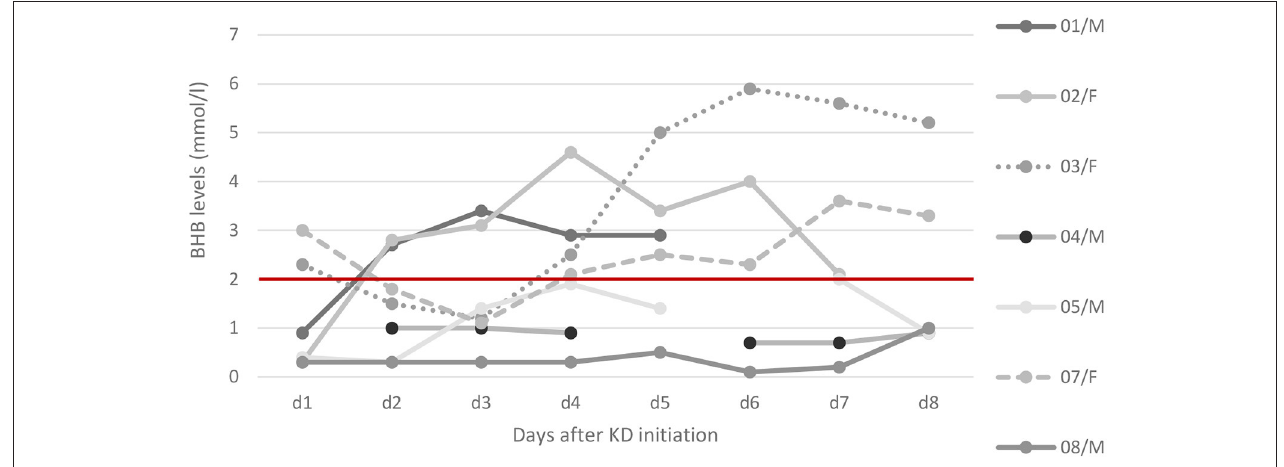
FIGURE 1 | Ketosis after KD initiation. Ketone levels of beta-hydroxybutyrate (BHB) in serum as trajectories from day 1 to day 8. Relevant ketosis ( > 2 mmol/l) is marked above the red line. Detailed data on ketosis within the first days of KD were available in seven patients: while five patients reached relevant ketosis, the other two (patient 8 and patient 4) showed maximum levels of 0.7 and 0.2 mmol/l, respectively. In patient 8 (FIRES) corticosteroids were administered 3 days before KD start and overlapped for the first 3 days hence delaying ketosis.